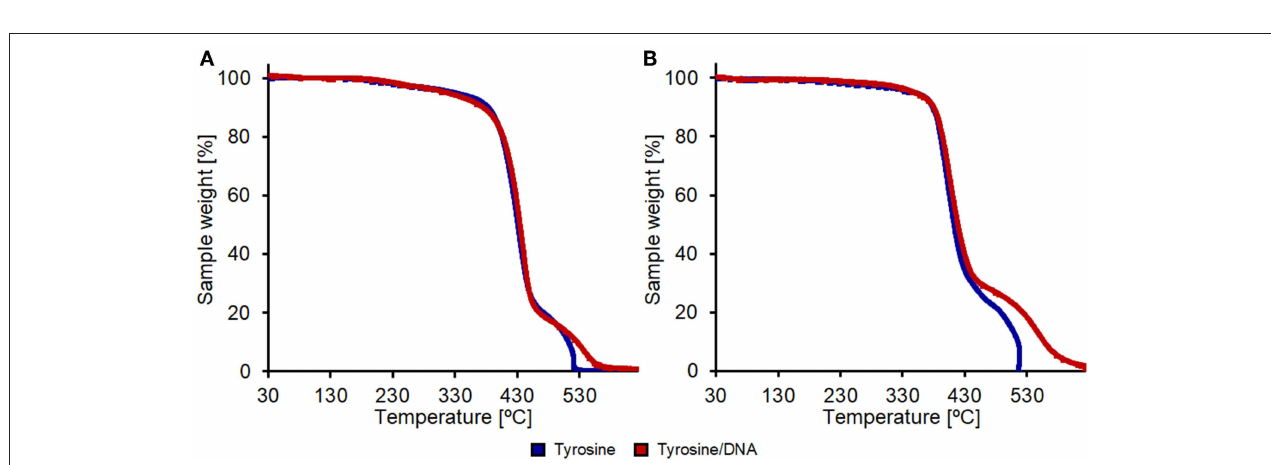
FIGURE 10 | Thermal degradation analysis in air of PET (A) and nylon (B) samples. All samples were enzymatically hydrolyzed and coupled with only tyrosine (blue lines) or with tyrosine and DNA (red lines).